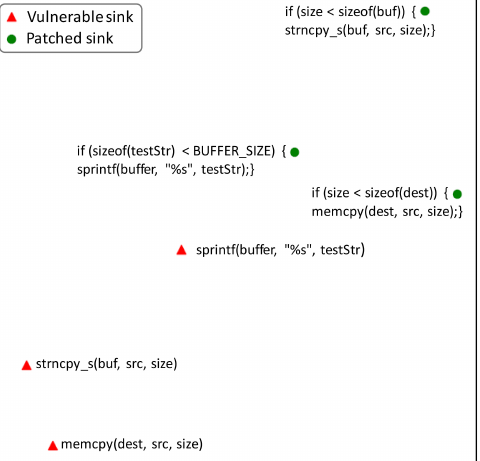
Figure 3. A plot of the ELMo representations of three vulnerable sinks and their corresponding patched versions. The representations are 1024-dimensional vectors output from the mean-pooling layer of the ELMo module, which are projected onto a 2D plane using t-SNE (with perplexity = 2.2). The red rectangles are the representations of the vulnerable sinks missing proper validation. The green circles are the representations of the patched sinks using if statement for validation. The figure depicts that the ELMo module could produce distinct representations for vulnerable sinks and non-vulnerable ones based on their context (i.e., having if statement for validation or